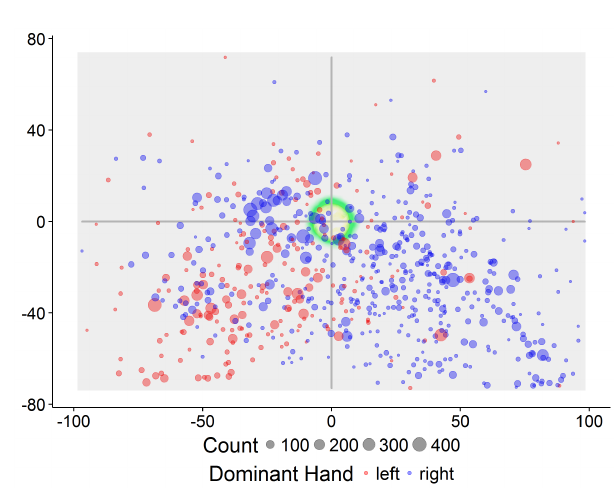
Figure 10. Average position of all unintentional touches per session (N=701) from the center of the screen by left (red) and right (blue) input hand, size by the count of contributing touches and all superimposed onto the screen canvas (gray) including the WAM center button.